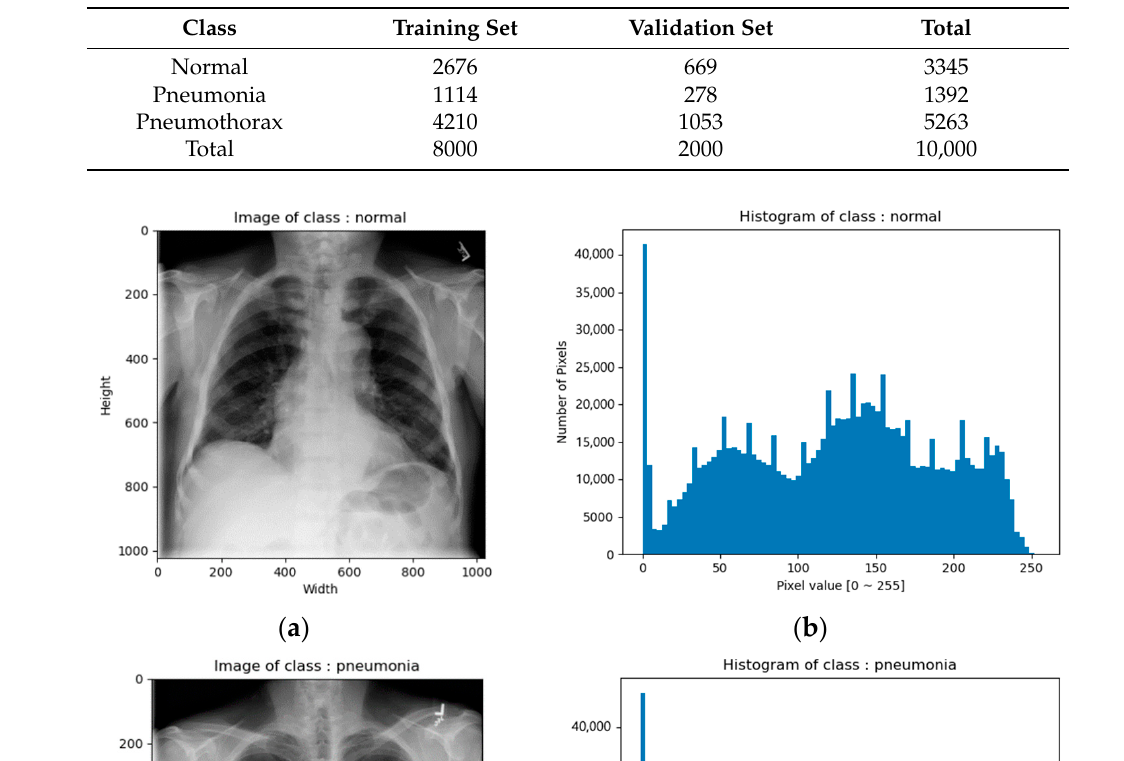
Table 1. NIH data set.